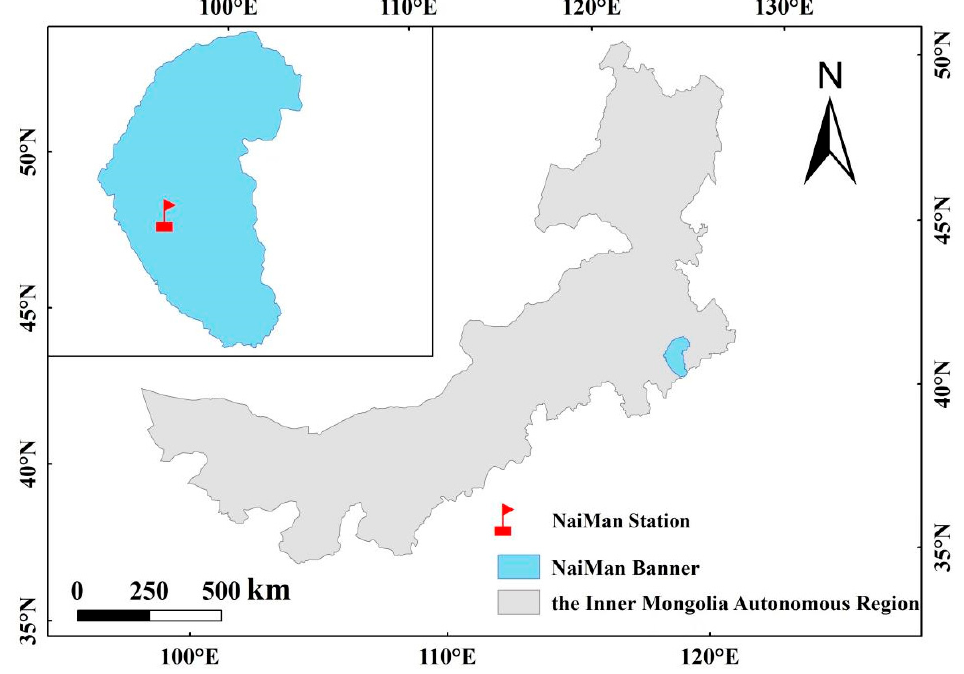
Figure 1. Location of the study area.